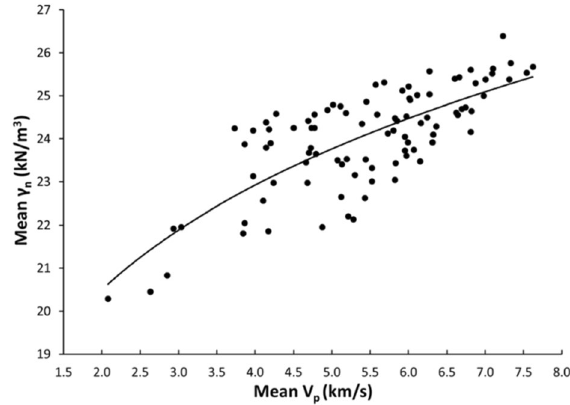
Figure 8. Relationship between the V p and γ n of limestone.